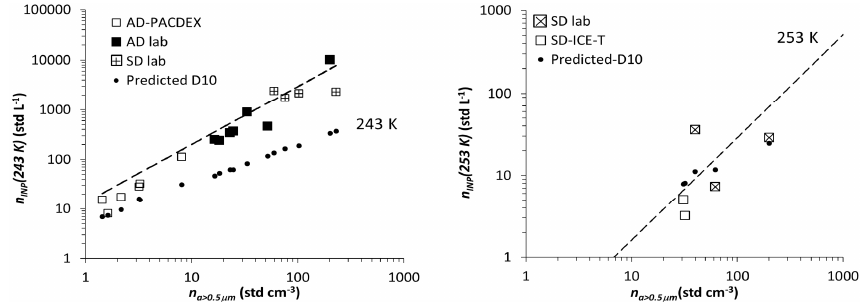
Figure 7. As in Fig. 5, but comparing raw (Fig. 5) and predicted (cf = 1) results to the D10 parameterization (calculated for the same data) at nominal temperatures of 243 and 253K. Note that the D10 parameterization does not produce a straight line in the panel figures due to the variation of temperature within 1K that was allowed in the analysis.